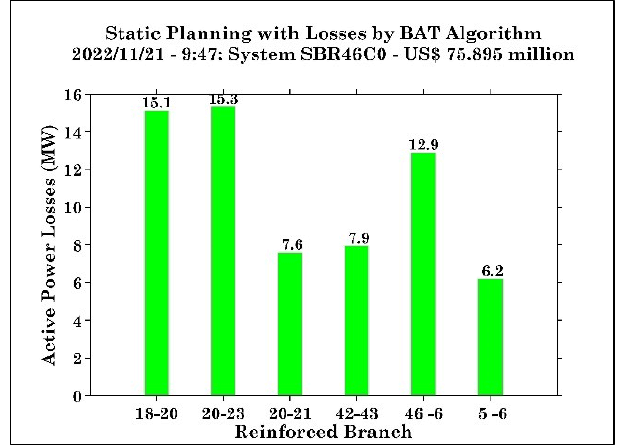
Figure 17: Case WR - SB-46/79 t est system. Losses in the branches. Source: BATp optimizer, (2022).